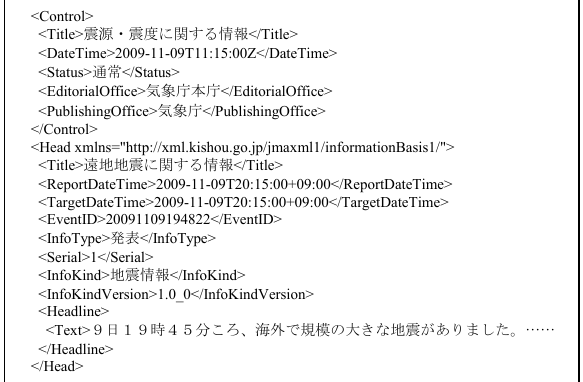
Figure 1. JMA DPI XML data format